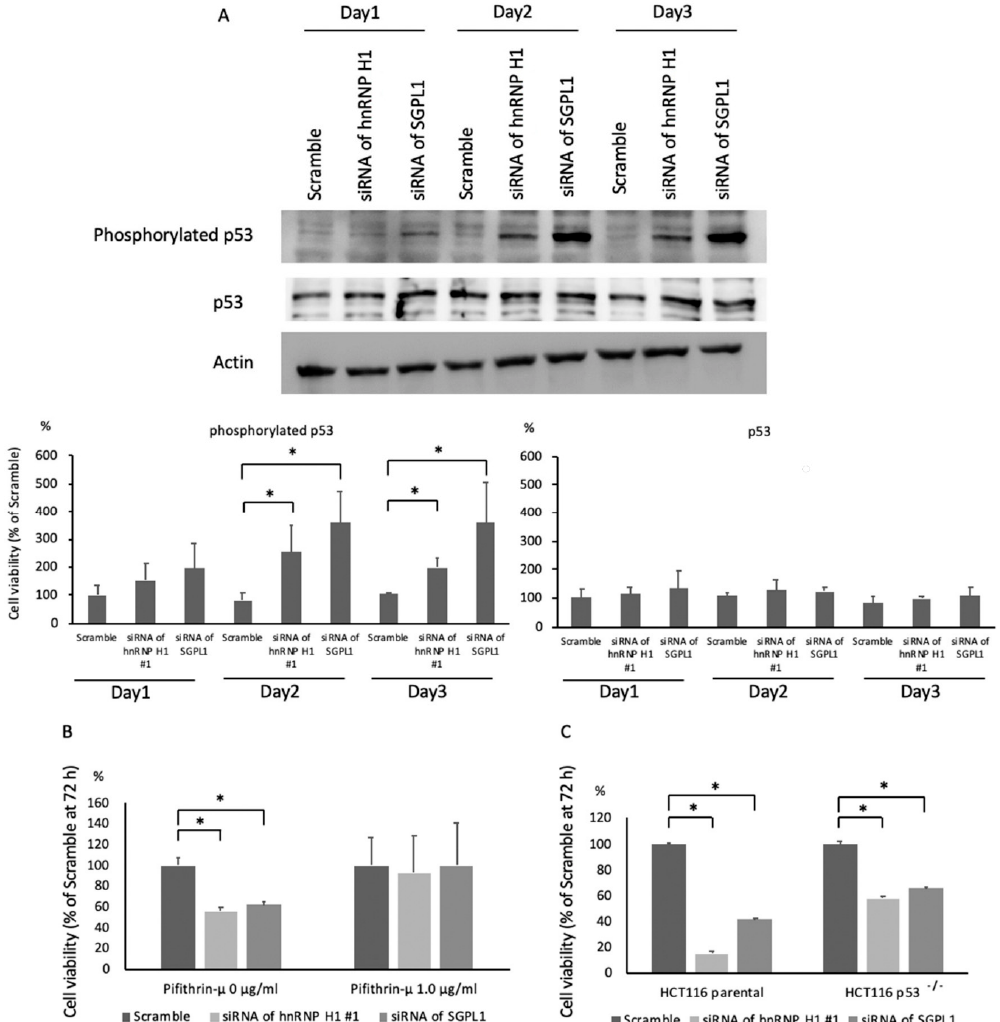
Figure 6. siRNA of hnRNP H1 or SGPL1 upregulated p53 phosphorylation and inhibited cell growth. ( A ) Western blotting ( n = 3) revealed that phosphorylated p53 was significantly increased in hnRNP H1- and SGPL1-downregulated cells, whereas p53 did not change. ( B ) The SRB assay ( n = 5) revealed that the tumor-suppressive e ff ect induced by downregulating hnRNP H1 or SGPL1 after 72 h in cultured HCT116 cells was diminished by treatment with the p53 inhibitor, pifithrin- µ . ( C ) The SRB assay ( n = 5) revealed that the tumor-suppressive e ff ect induced by downregulating hnRNP H1 or SGPL1 was less influential in HCT116 p53 − / − cells than in HCT116 parental cells ( C ). The error bars show the SD. * p < 0.05 by Student’s t